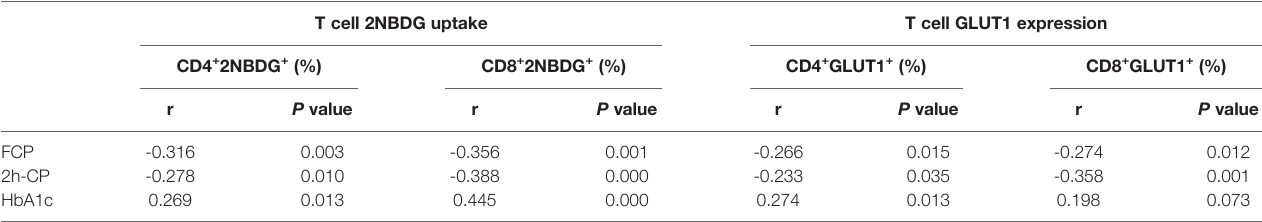
TABLE 2 | Correlation analysis between T cell glucose uptake and clinical indicators in